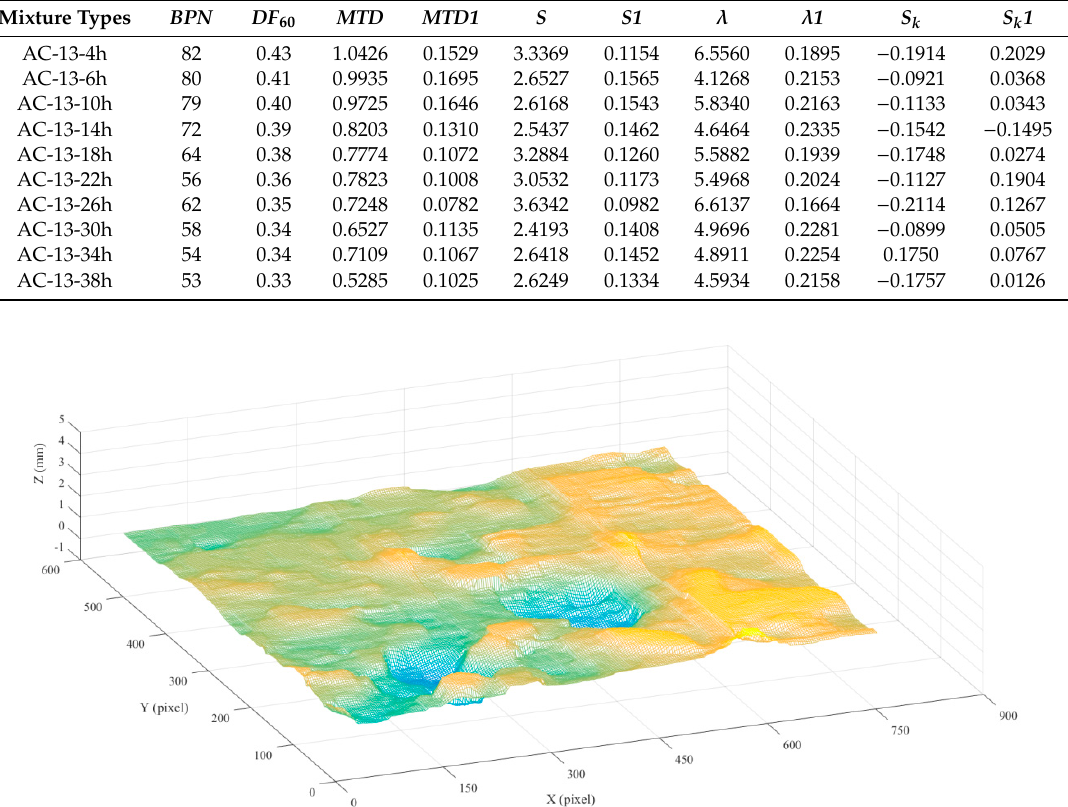
Figure 5. The 3D texture reconstruction results of AC-13(L)-4h.